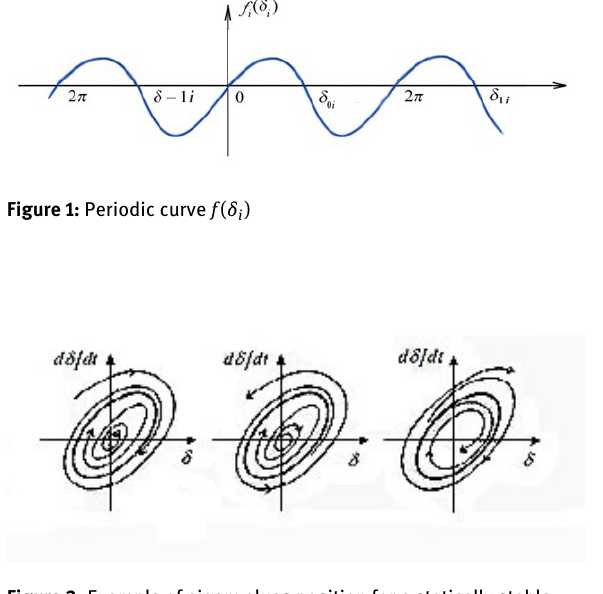
Figure 2: Example of eigenvalues position for a statically stable multi-machine electric power